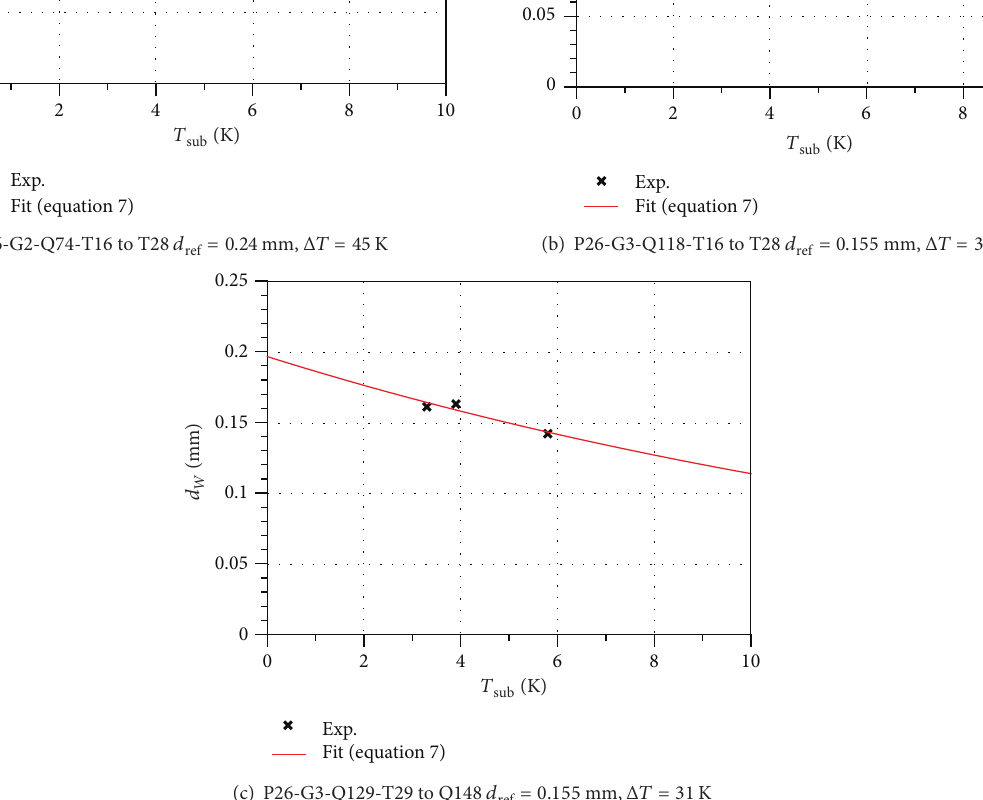
F 3: Bubble size at detachment according to (7) �tted to measurements.